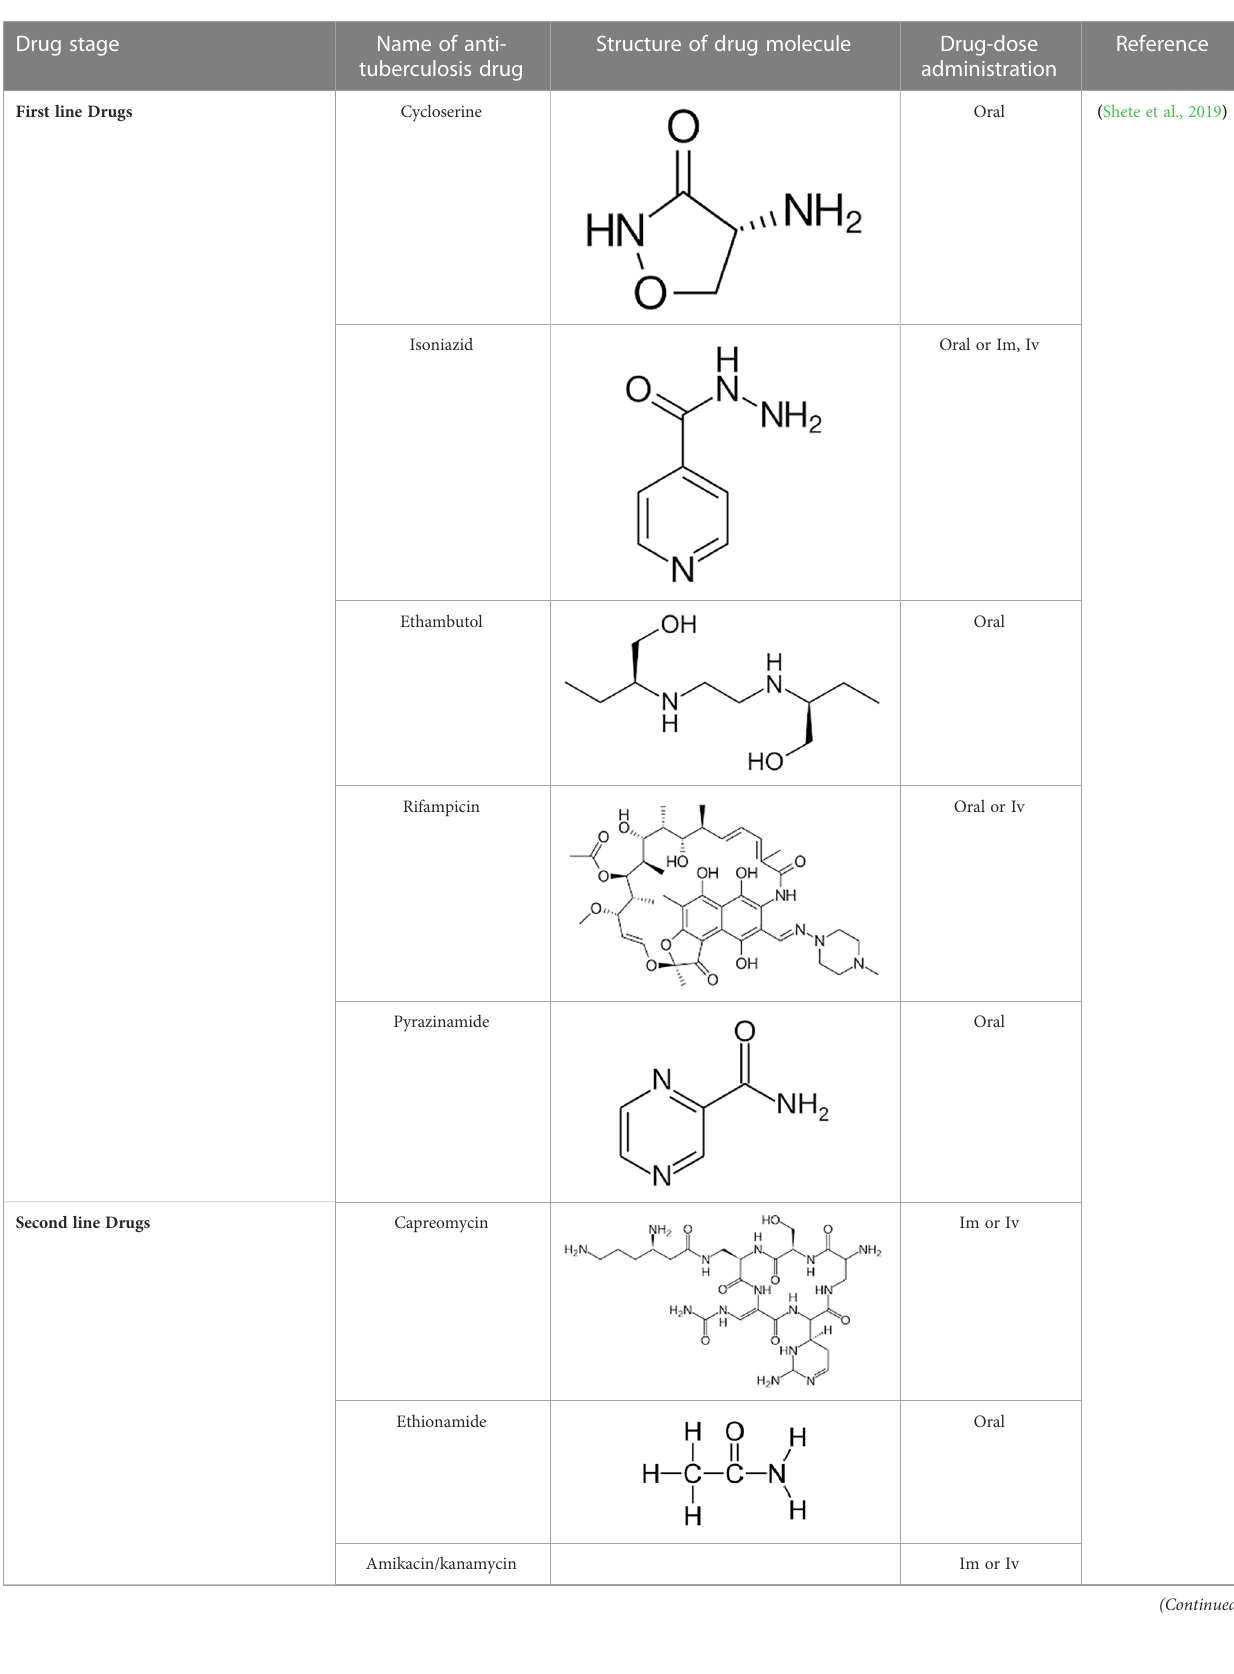
TABLE 1 Groups of drugs, molecular structure and route of drug administration in the human